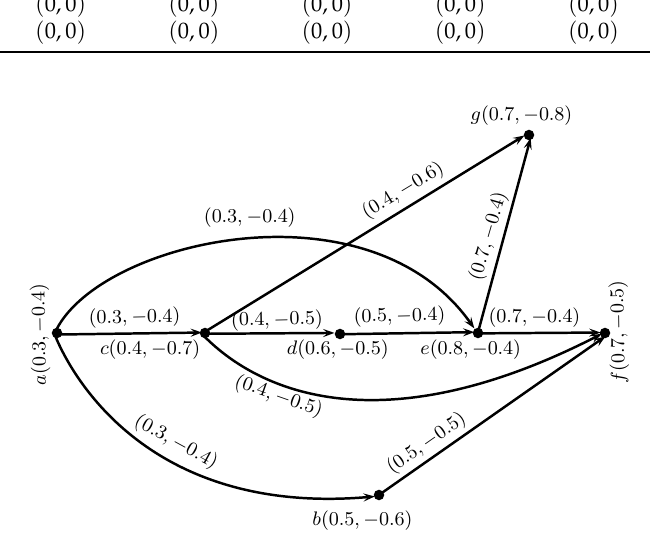
Figure 1. Bipolar fuzzy Figure 2.1: Bipolar fuzzy digraph